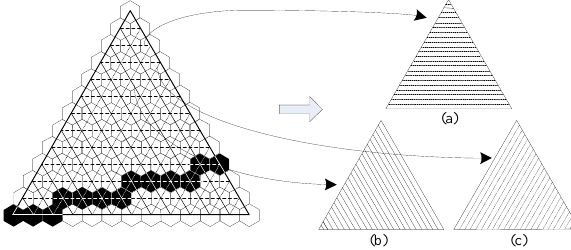
Figure 5. Three directions of lines arranged by hexagon grids on icosahedron triangular